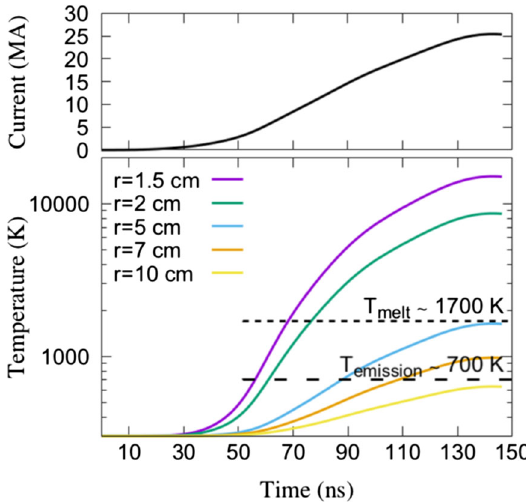
FIG. 6. Using the Knoepfel Ohmic heating equation [11] for applied current, the temperature at various radii is plotted for a typical Z pulse. Note the 700° point for typical plasma formation and the melt temperature for stainless